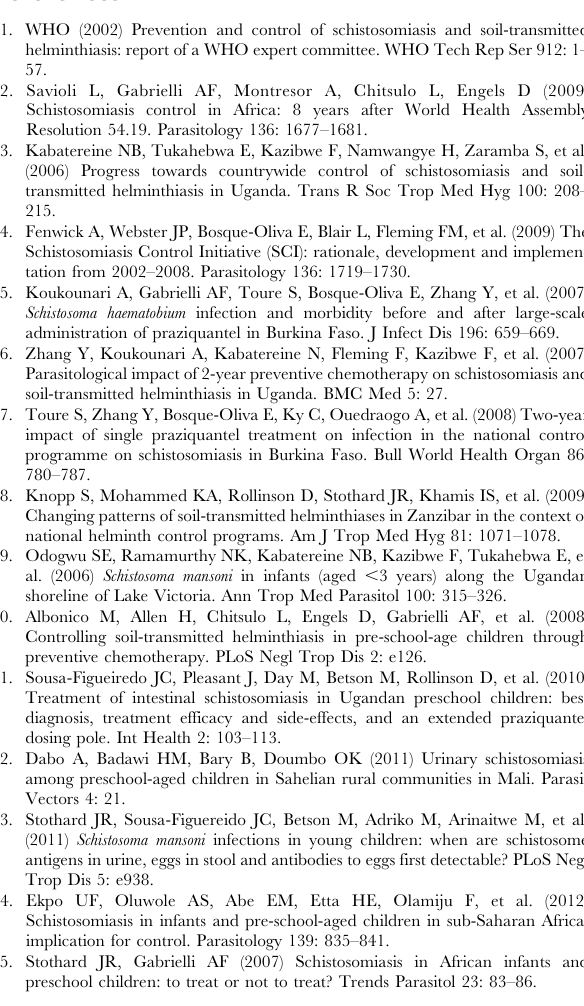
Table S1 Concordance between POC-CCA test scores from consecutive days 1 and 2 at individual level before and after